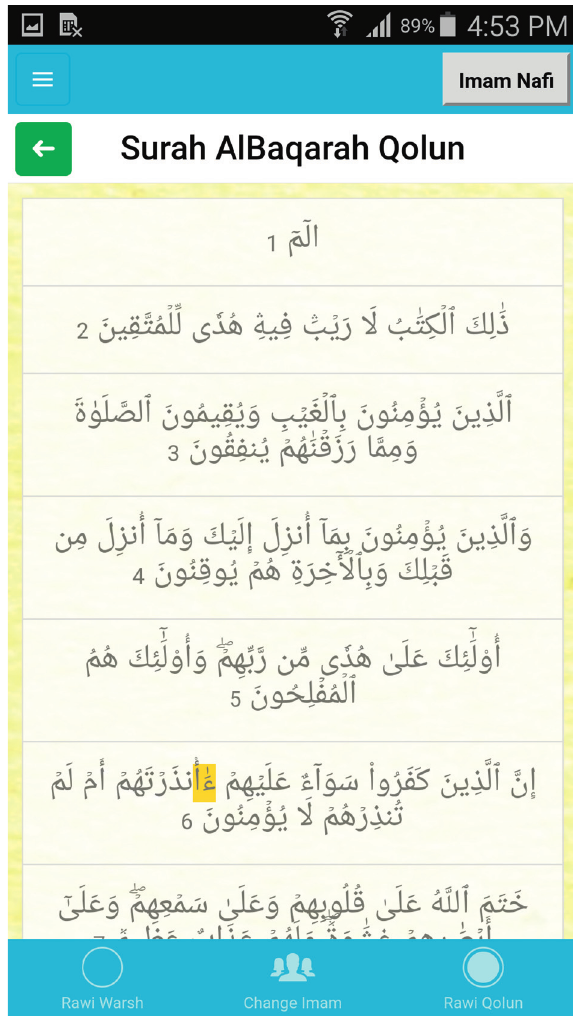
Figure 6: Surah Al Baqarah Qolun that has been selected. Figure 5: Surah Al Baqarah Warsh